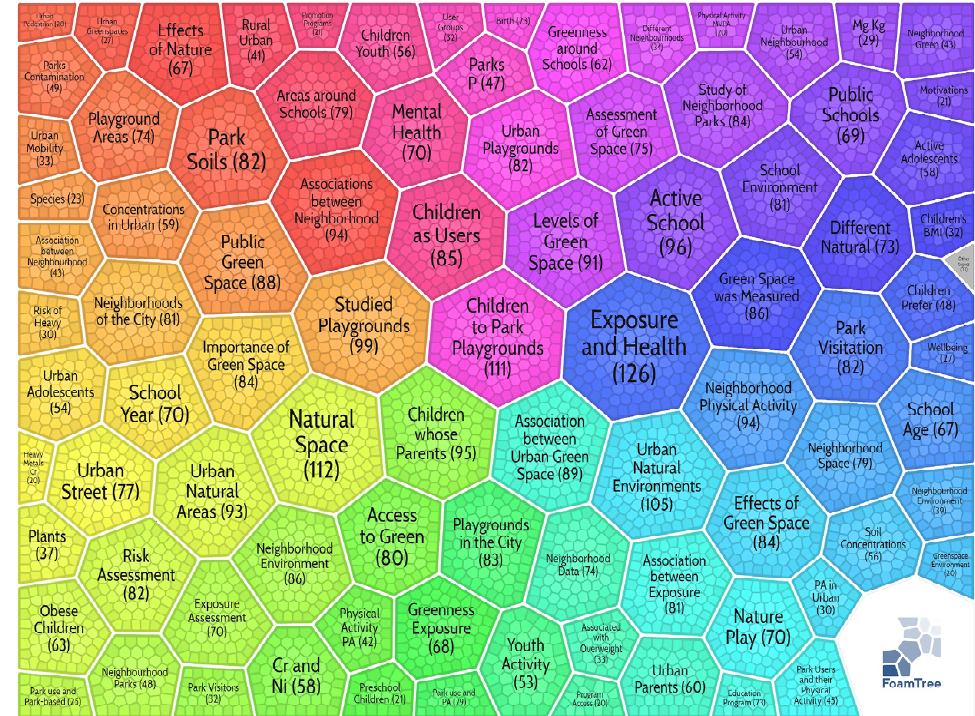
Figure 7. Visualization of the publication cluster foam tree.